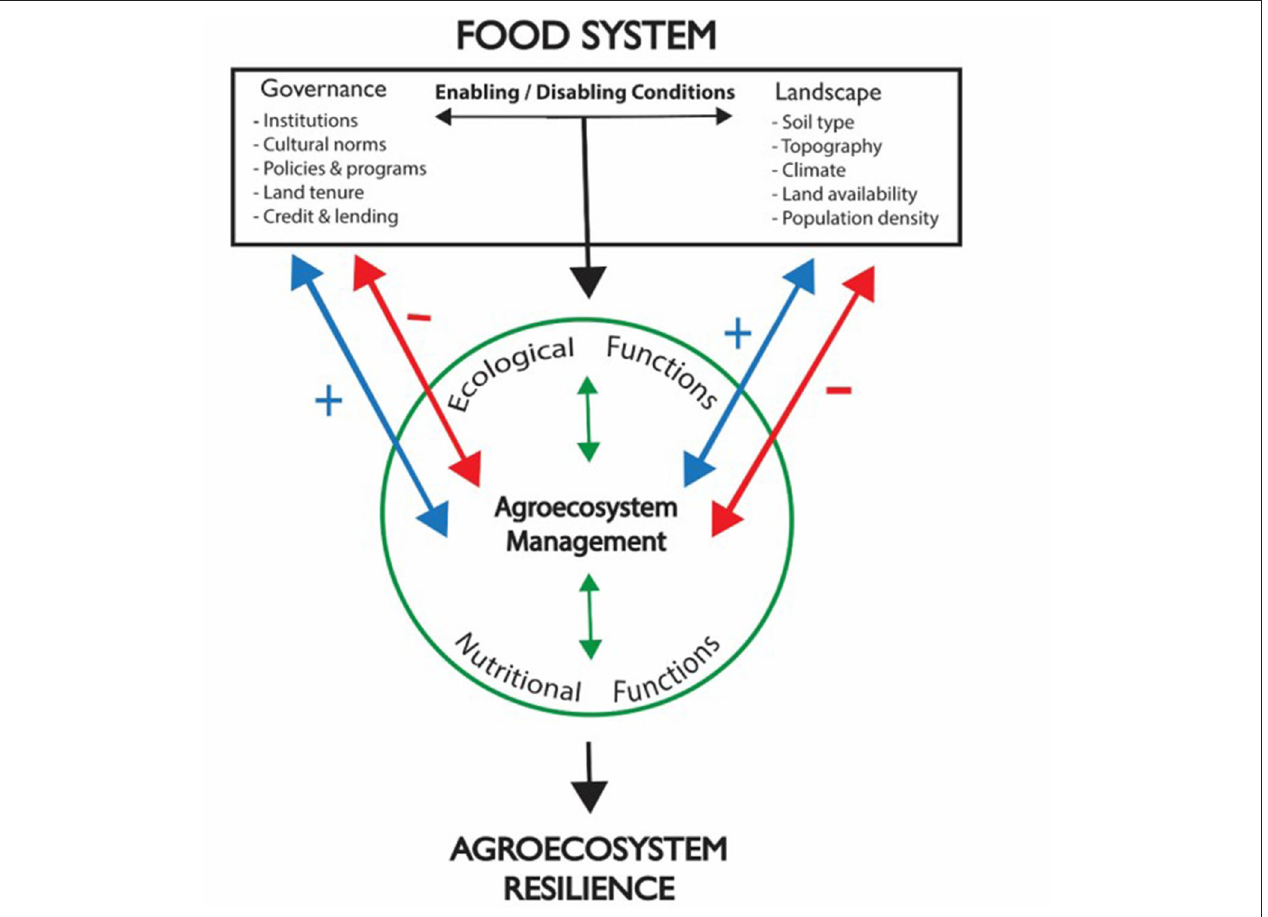
FIGURE 1 | Conceptual diagram of interactions between agroecosystem functioning and resilience. Farm management affects ecological and nutritional functions, which in turn drive changes in agroecosystem resilience. Green arrows inside the circle represent the interactions between ecological and nutritional functions, which are mediated by agroecosystem management practices and the adaptive capacity of farmers. Farm-level management decisions are embedded within food systems and associated governance and landscape conditions, which can trigger positive ( + ) or negative (–) feedbacks in